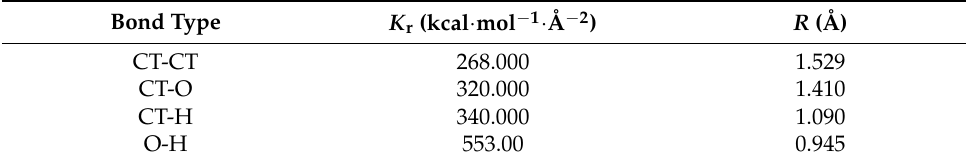
Table 2. Bond stretching parameters for alcohols.